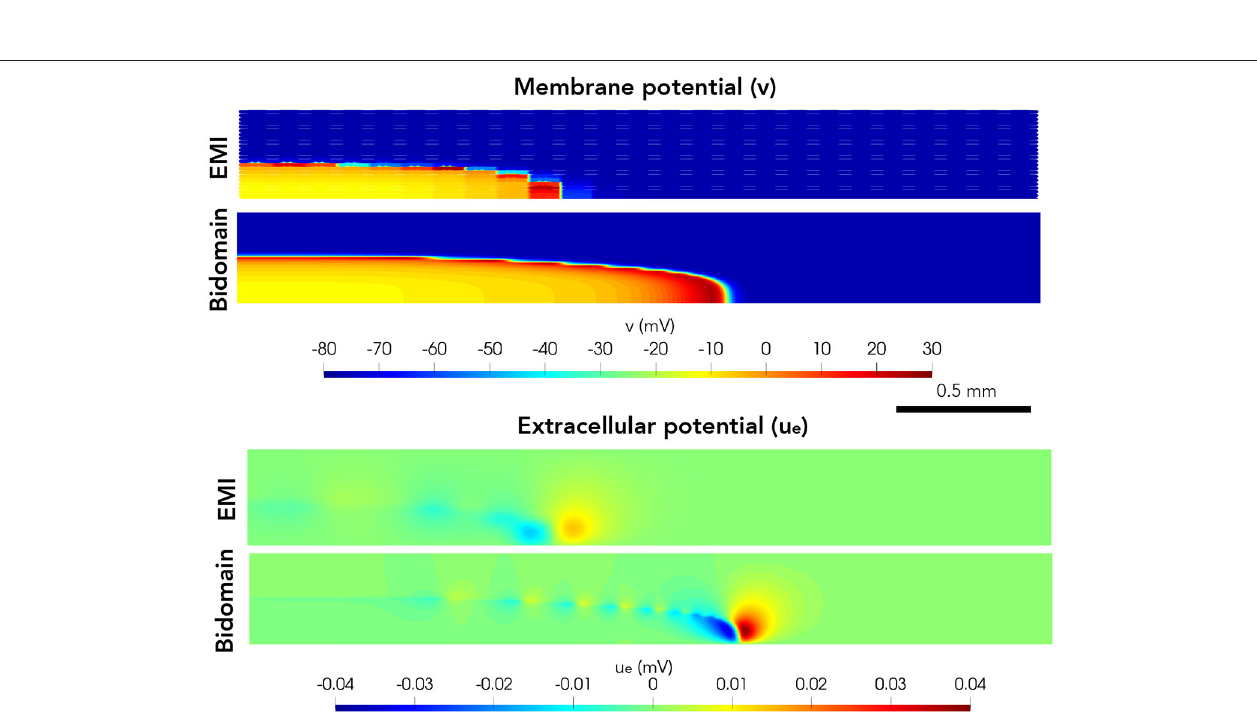
FIGURE 6 | Membrane potential, v , and extracellular potential, u e , at time t = 20 ms in EMI model and bidomain model simulations using and active membrane model (Jæger et al., 2021b) and the default parameter values specified in Table 1 , except that the value of R g is increased by a factor of 200.